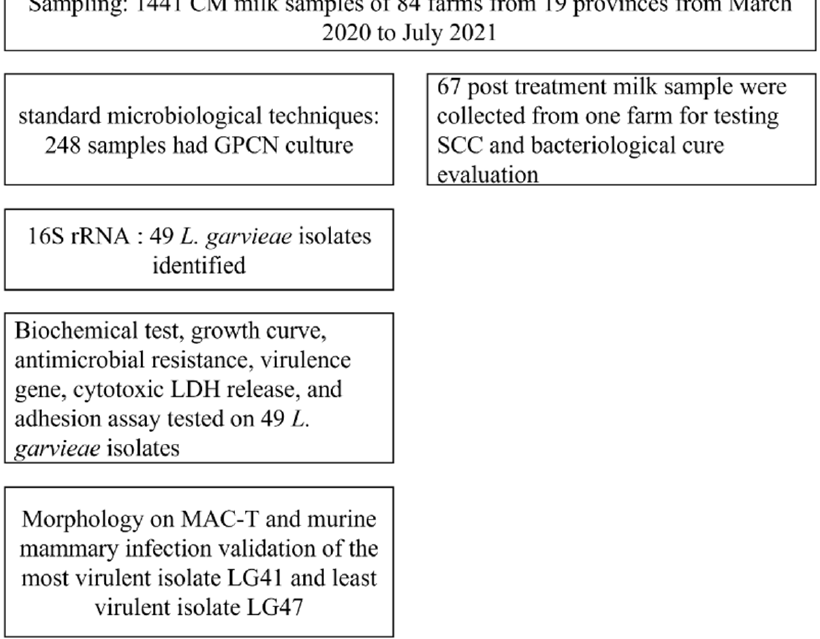
Figure 1. Flow diagram from sample collection and identification in the in vivo and in vitro study.